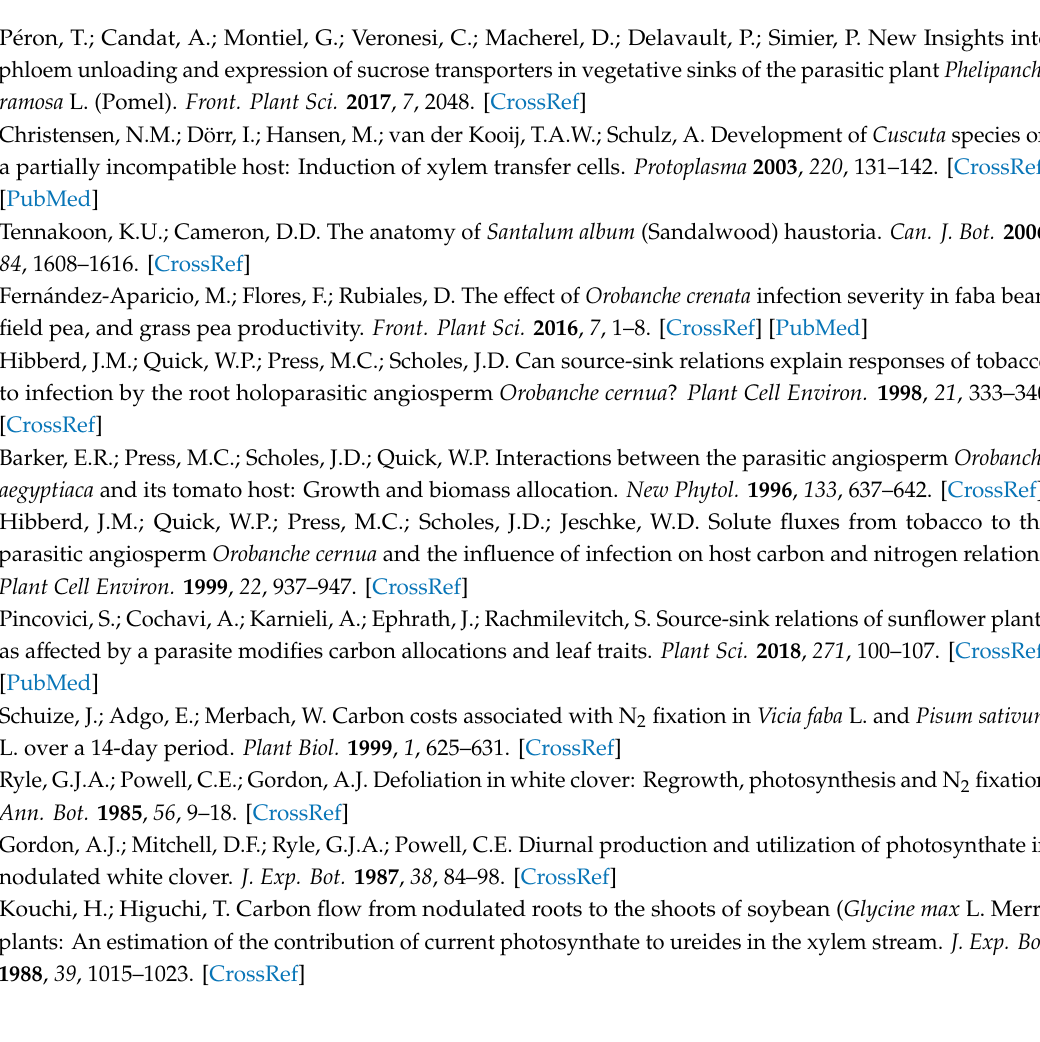
Table S1: Statistical analysis of log-transformed biomass data of parasitised and control clover plant biomass three and six weeks after the start of light and N treatments. Table S2: Belowground mass per unit shoot mass (mg mg − 1 ) of control or O. minor -infected Trifolium pratense plants grown under high and low light levels, and either supplied or deprived of exogenous nitrogen. Table S3: Results of a 3-way ANOVA of clover host leaf physical properties in the presence or absence of parasitism by O. minor , Table S4: Results of a 3-way ANOVA of clover host leaf photosynthetic properties in the presence or absence of parasitism by O. minor. Table S5: Results of a Factorial ANOVA of clover host leaf biochemical properties in the presence or absence of parasitism by O. minor